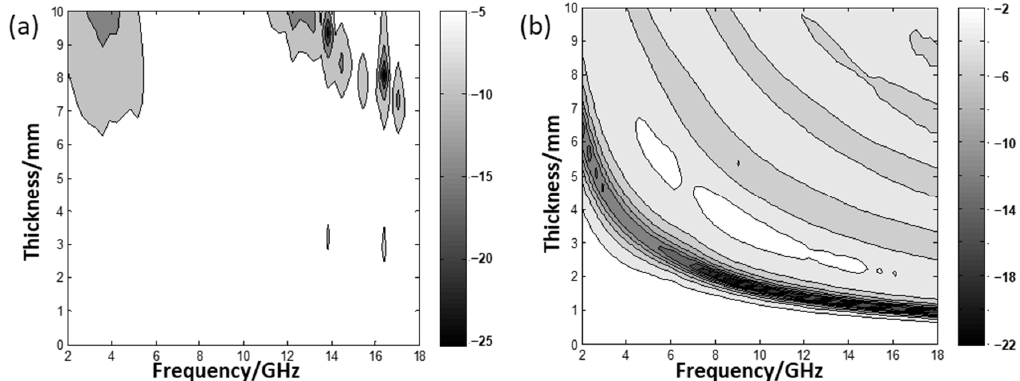
Figure 5. The electromagnetic parameters of ( a ) NiFe 2 O 4 and ( b ) NiFe 2 O 4 /MWCNTs composites.